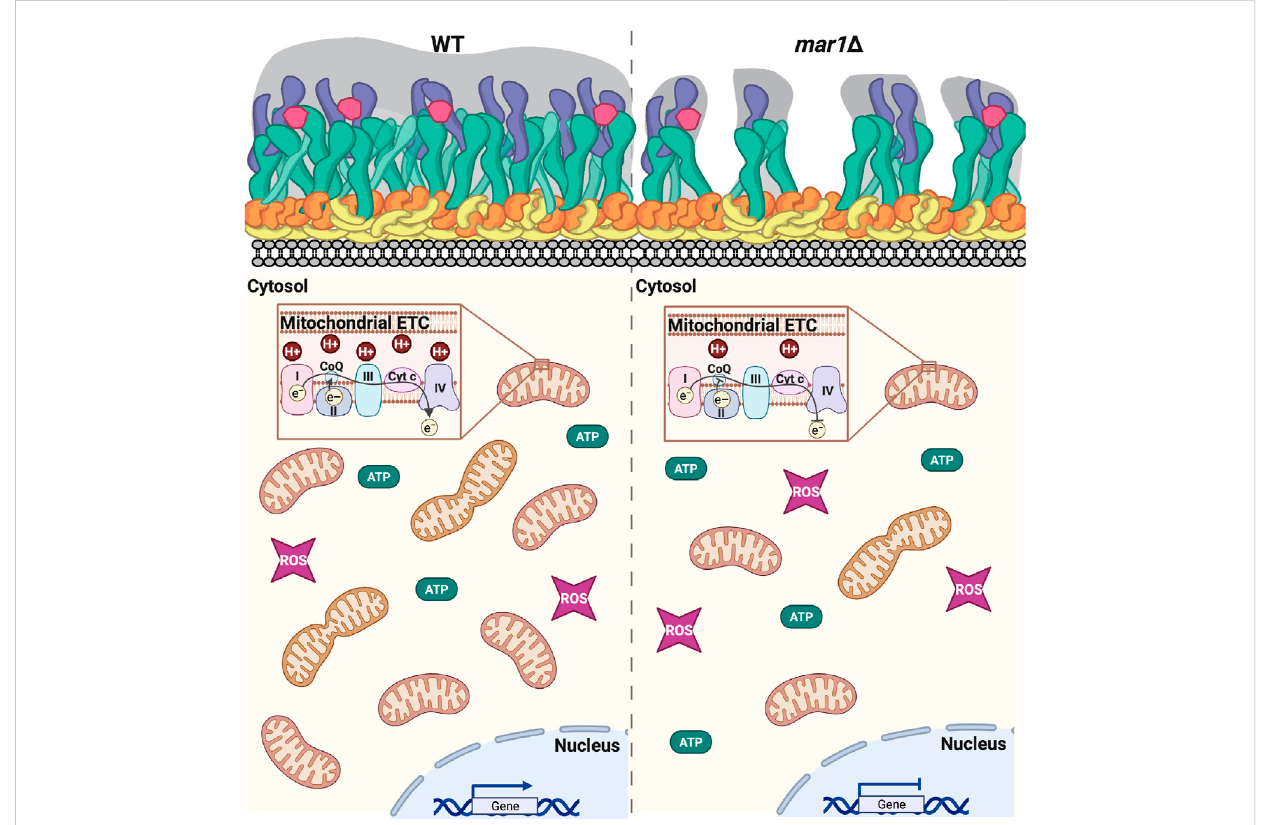
FIGURE 10 Working model of mar1 Δ mutant strain phenotypes. As previously described, in response to host-like stressors, the WT strain remodels its cell surface by thickening its cell wall and extending its polysaccharidecapsule (Esher etal., 2018). In thiswork, we fi nd that the WT strain also adapts to these conditions by altering expression of nuclear-encoded genes involved in mitochondrial function increasing its mitochondrial mass, increasing its mitochondrial membrane potential, and reducing its total cellular ATP. The mar1 Δ mutant strain is impaired in these adaptive cellular responses to host-like conditions. As previously described, compared to the WT strain, the mar1 Δ mutant strain has attenuation in cell wall thickening; the mar1 Δ mutant strain displays increased chitin exposure likely due to decreased levels of glucans and mannans in the outer cell wall layers and subsequent decreased polysaccharide capsule extension in response to host-like stressors (Esher et al., 2018). In this work, we fi nd that the mar1 Δ mutant strain has aberrant expression of nuclear-encoded genes involved in mitochondrial function, decreased mitochondrial mass, decreased mitochondrial membrane potential, and altered ATPmetabolism.Collectively, these dataimplicate Mar1 inregulation ofmitochondrialmetabolismand homeostasis,particularlyin the presence of stress. Cartoon adapted from BioRender.com (2022). Cell surface components: yellow = chitin; orange = chitosan; green = β -glucans; purple = α -glucans; pink= mannoproteins;gray =polysaccharide capsule. ETC., electrontransportchain. CoQ, coenzyme Q.Cyt c, cytochrome c. ROS, reactive oxygen